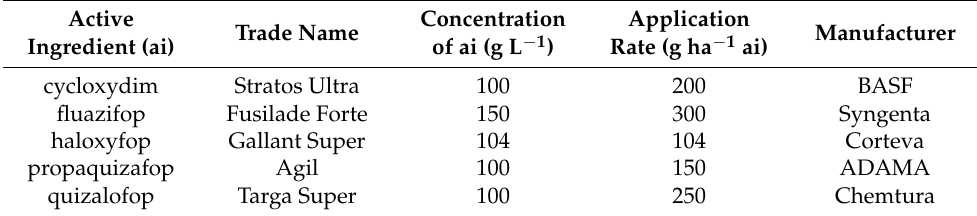
Table 2. Description of tested herbicides.